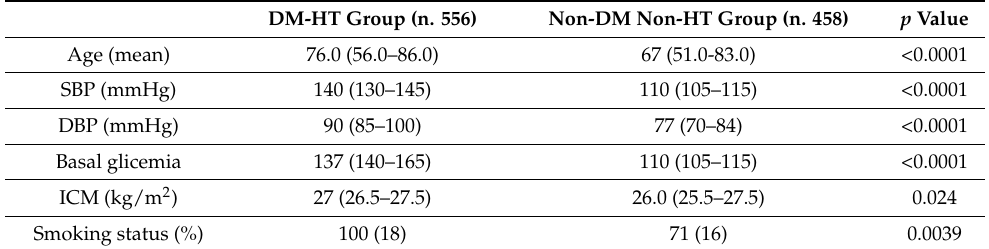
Table 3. Gender differences in DM-HT groups. ICU (intensive care unit), CT (computerized tomography), high-flow nasal cannula (HFNC). Male (n. 286)